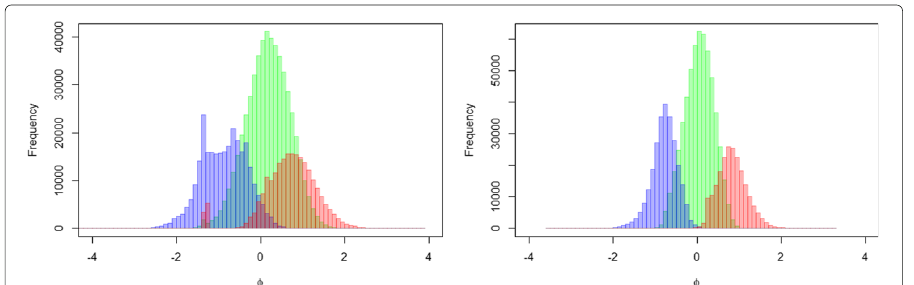
Fig. 3 Distributions of the Helmholtz-Hodge potential for firms in the IN component (red), GSCC (green), and OUT component (blue) of the TSR transaction network. The left and right panels show the results for the original network and one sample of the randomized networks with the same degree sequence, respectively